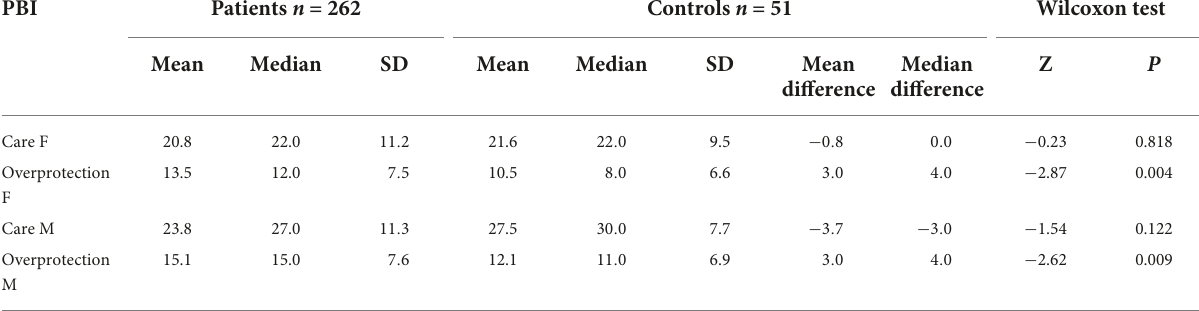
TABLE 2 Comparison of the caregiver style between patients and volunteers. PBI